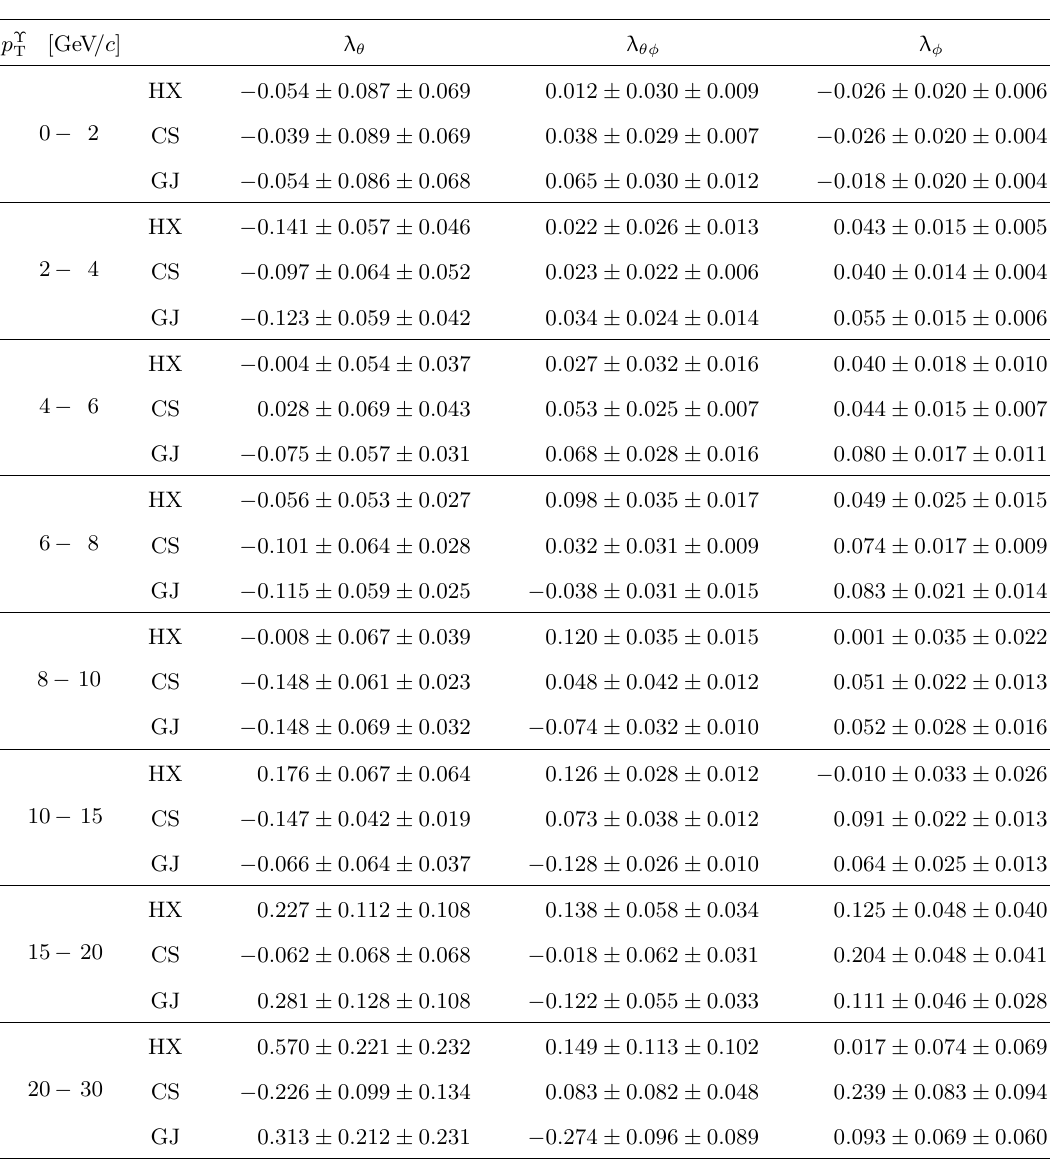
Table 26 . Values of (cid:21) (cid:18) , (cid:21) (cid:18)(cid:30) and (cid:21) (cid:30) measured in the HX, CS and GJ frames for the (cid:7)(3S) produced p at s = 7 TeV in the rapidity range 2 : 2 < y (cid:7) < 4 : 5. The (cid:12)rst uncertainty is statistical and the second